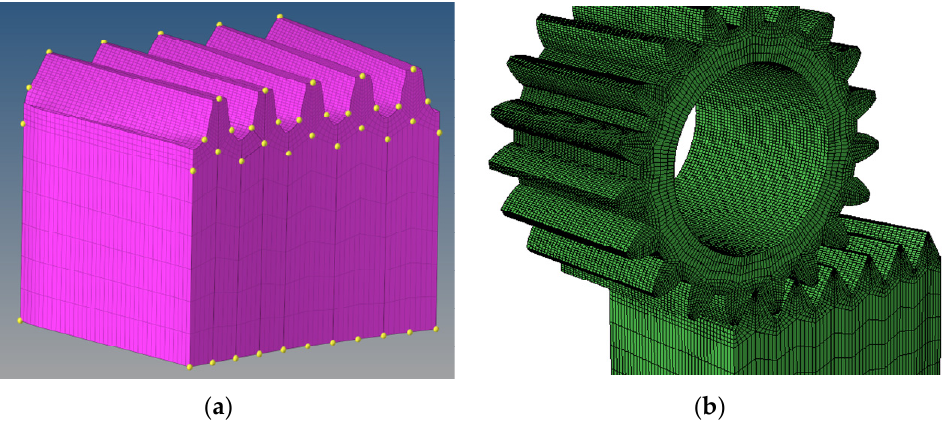
Figure 10. FEM: ( a ) Mesh generation, ( b ) the finite element model of real five-pairs-of-teeth face gear drive.